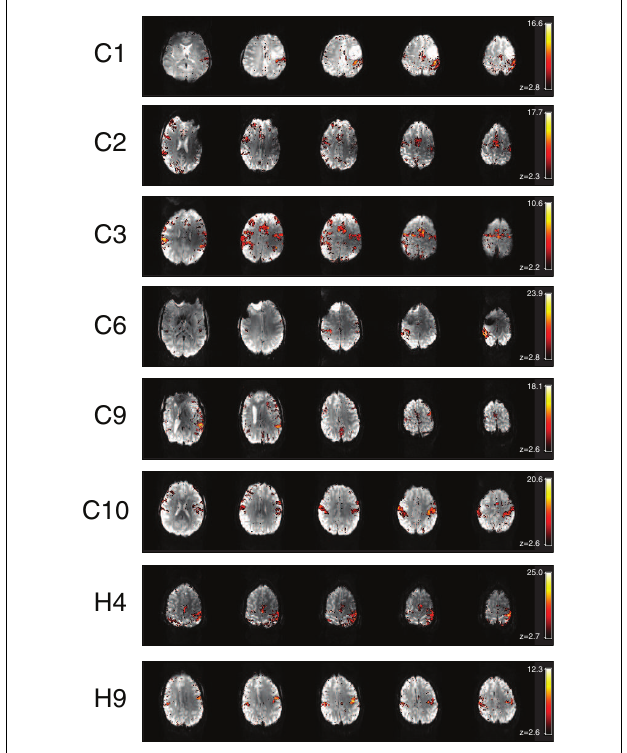
FIGURE 5 |Additional motor components identified in the ICA results of chin patients C1, C2, C3, C6, C9, C10, H4, and H9.